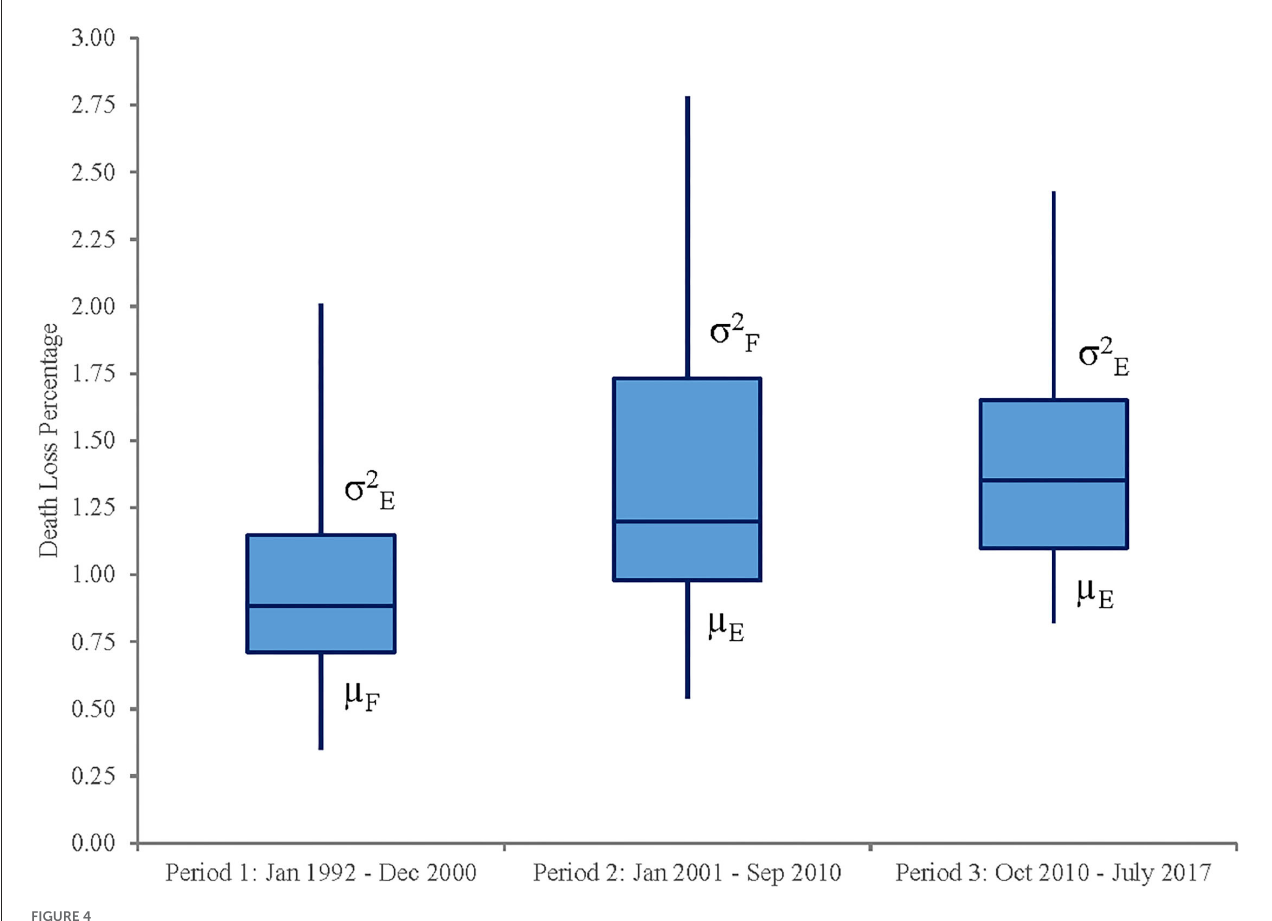
FIGURE4 Box plot of death loss percentages for steers by